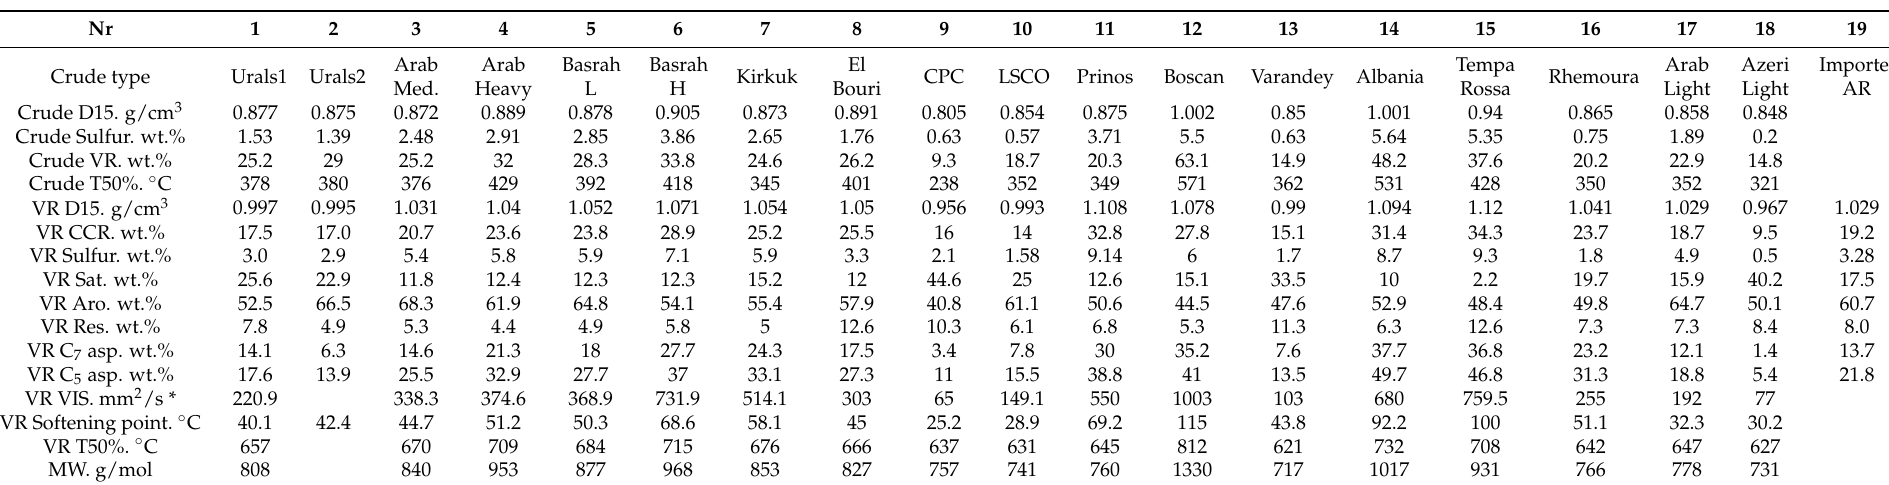
Table 1. Physicochemical properties of studied crude oils and vacuum residue fractions derived